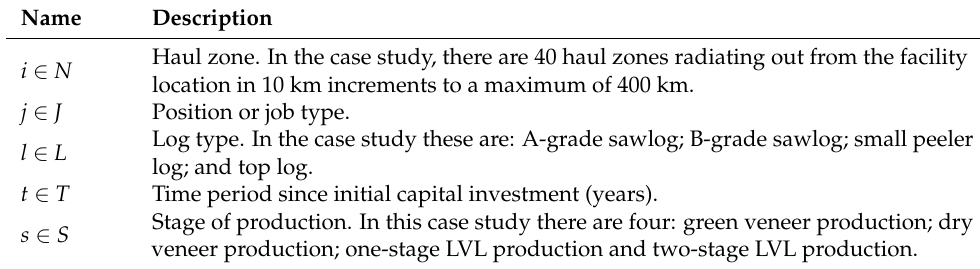
Table 2. Index sets used in the mathematical model.